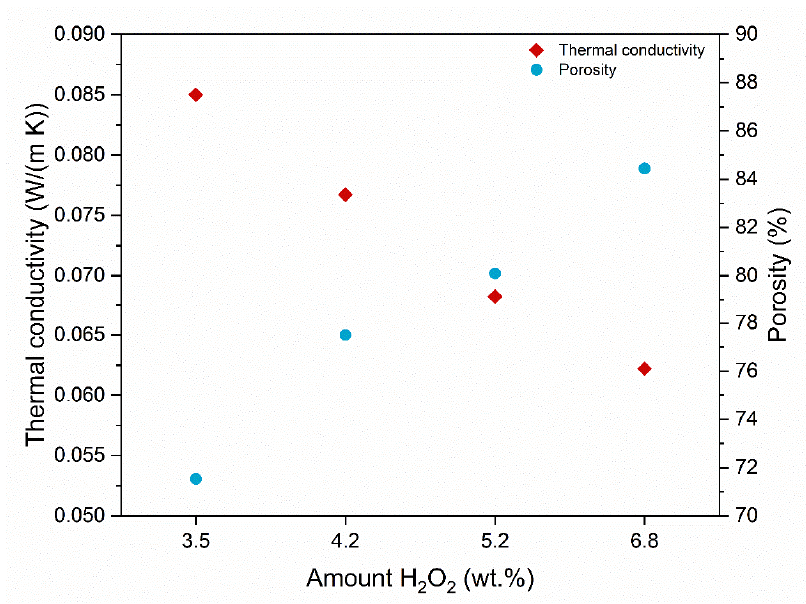
Figure 9. Porosity and thermal conductivity of geopolymers with different amounts of H 2 O 2 , according to Reference [73] .